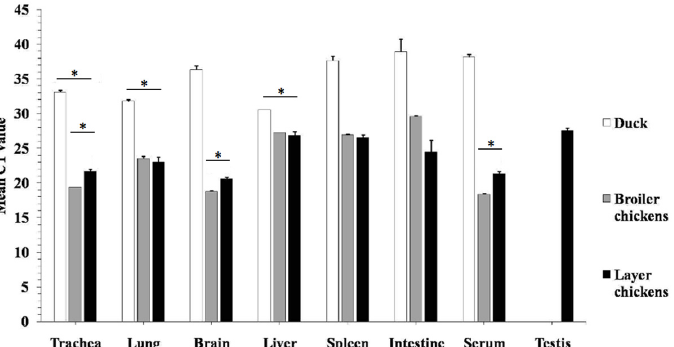
Fig 2. Detection of M gene transcripts by RT-PCR. Results were expressed as C t values; C t values lower than (35) were considered positive; C t values between 15 and 25 were considered strong positive, while those between 25 and 30 were considered moderate positive; C t values between 30 and 35 were considered weak positive. The tests were performed in triplicates for each sample and the C t numbers are average with 3xSD ( * P <